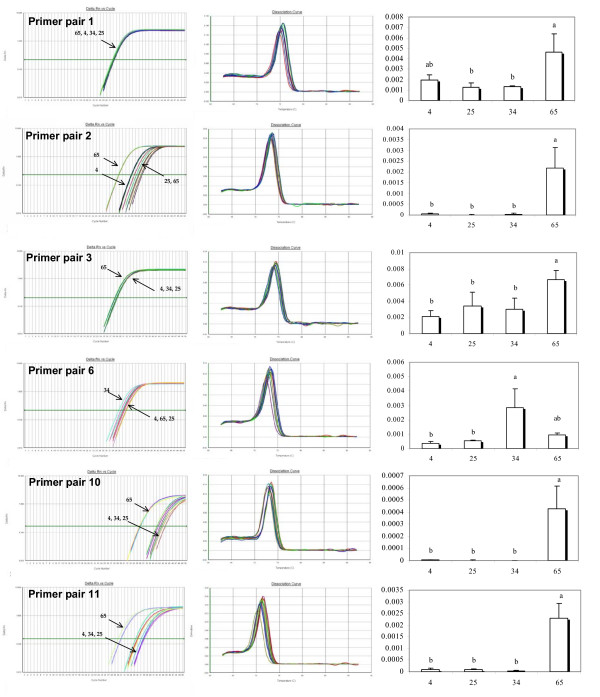
Outcomes of level of cDNA expression across families for primers (1, 2, 3, 6, 10, 11) technically validated through the analysis of the melting curve of the EST [EX956386]. From left to right: Plot of PCR cycle number against logarithm PCR product amount; Derivative Melting Curve; Statistical results of level of cDNA expression across families based on a multiple comparison test (Tukey). Family numbers are reported on the horizontal axis, histograms sharing a letter are not significantly different (P < 0.05).